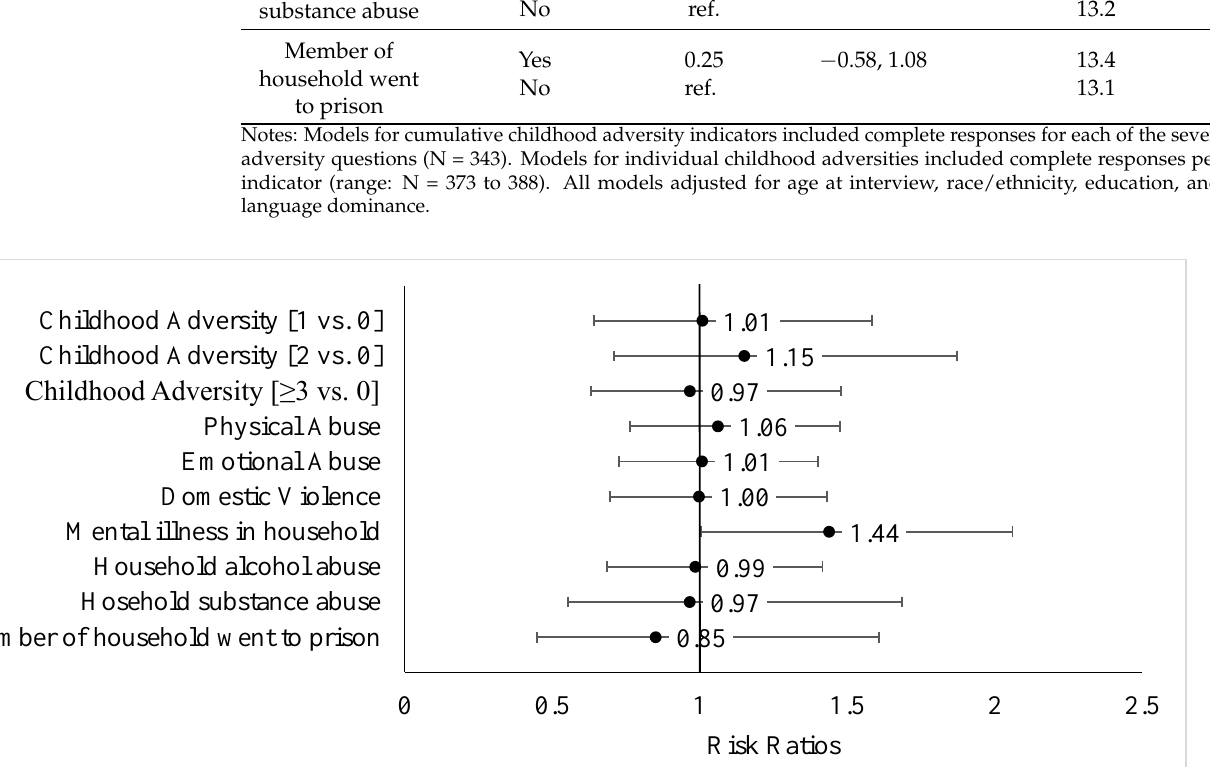
Figure 2. Adjusted associations of childhood infection (tonsillitis and mono) with early age at menarche (<12 years), rela- tive risk ratios, and 95% confidence intervals. Notes: Models for childhood infection included complete responses for each of the infection history questions (N = 352). All models adjusted for age at interview, race/ethnicity, education, and lan- guage dominance. Model for ever vs. never tonsillitis also adjusted for ever mono. Model for ever vs. never mono also adjusted for ever tonsillitis.